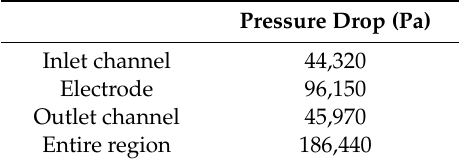
Table 5. Pressure drop in inlet and outlet channels, electrode, and entire flow